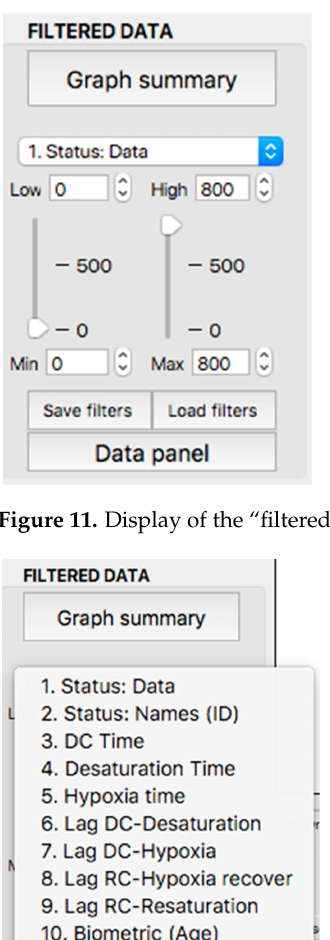
Figure 12. Display of the variable selector subpanel.